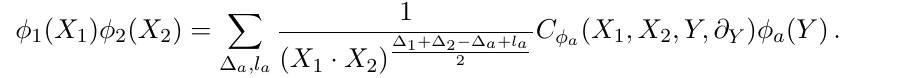
Figure 4. Scalar five point function (left), which in the OPE limit of fields φ 1 and φ 2 gets reduced to the 4-point function with a spinning leg φ and φ gets fully reduced to a type I vertex 5